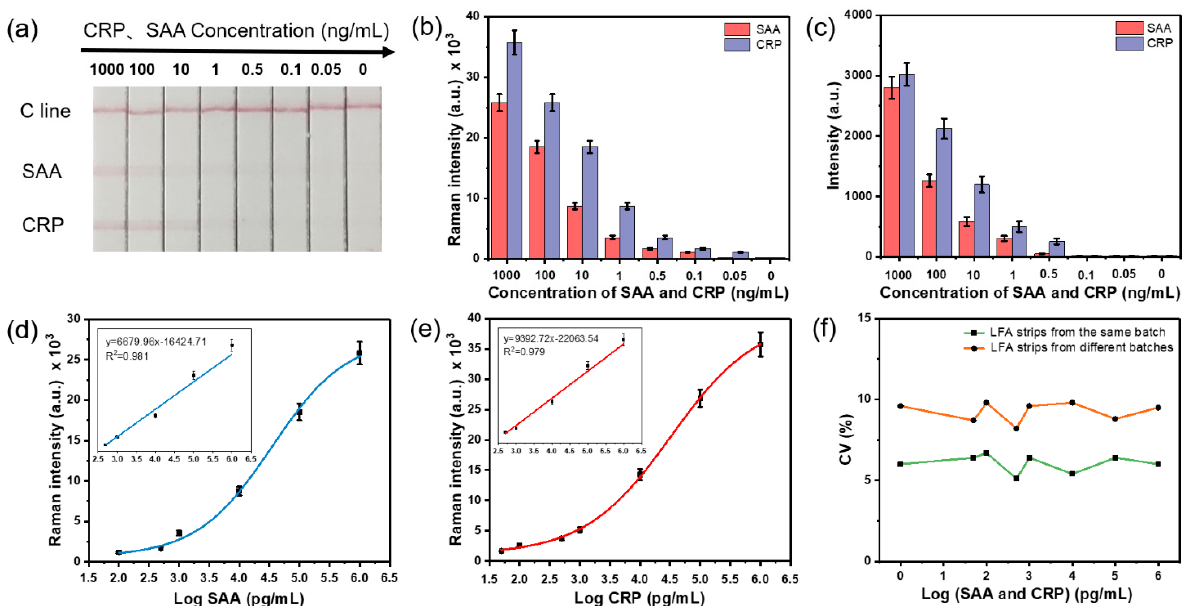
Figure 4. ( a ) Photograph of the test SERS-LFA strips at different SAA and CRP concentrations. ( b ) The corresponding Raman intensities at 1079 cm − 1 and ( c ) brightness values (by ImageJ) of two test lines. The Raman intensities and calibration curves of the corresponding test lines of ( d ) SAA and ( e ) CRP. The insets in ( d , e ) show the linear relationship of the calibration curve within a certain concentration range. ( f ) Coefficients of variation (CVs) of the SERS-LFA strips for simultaneous and quantitative detection of different concentrations of SAA and CRP. The error bars indicate the standard deviations calculated from five separate experiments.